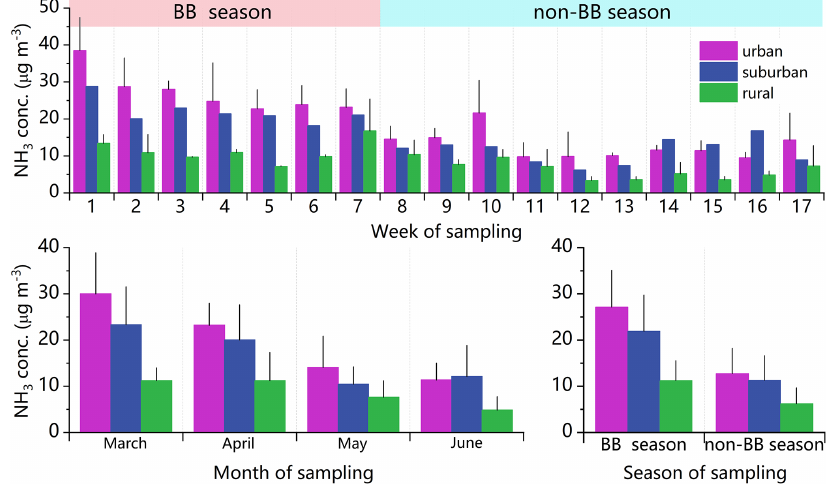
Figure 4. Temporal variations in measured NH 3 concentrations (µgm − 3 ) between sites with different land use regimes. The error bar indicates 1 standard